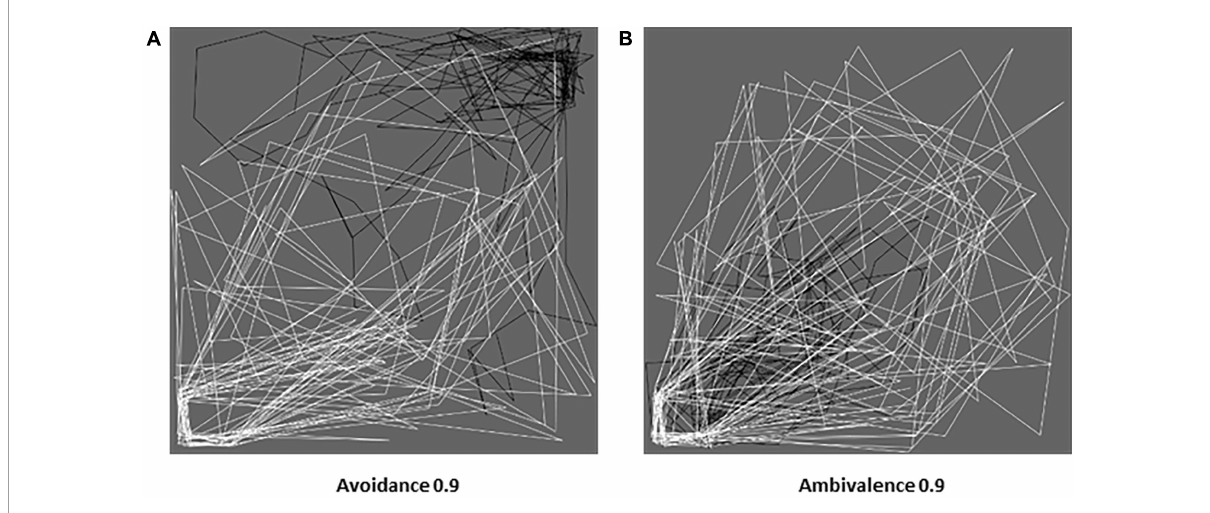
FIGURE10 Avoidant and ambivalent dyads in action. Simulated trajectories (black for the child, white for the mother) followed by the extremely avoidant (A) and ambivalent (B) dyads (dimensional level 0.9, iterations 800–1,000). The comparison of the two pictures (extracted from Figures 8 , 9 ) offers a glimpse of the different behavioral effects in the case of avoidant hyper-independence (A) and ambivalent hyper-dependence (B)